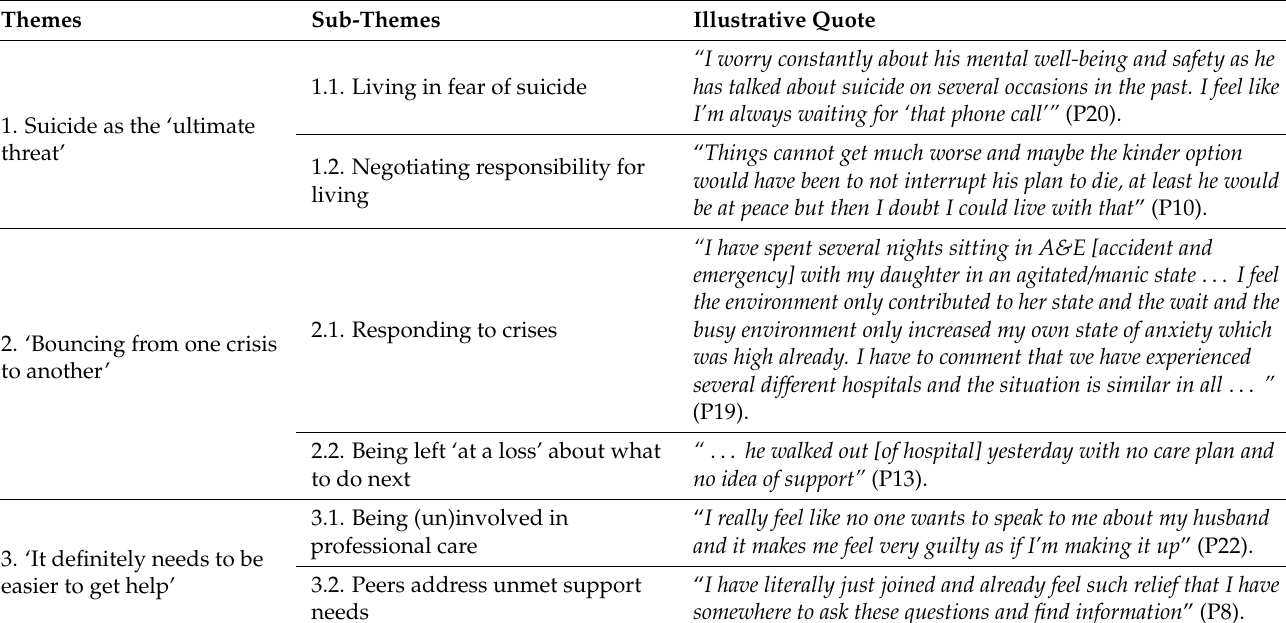
Table 2. Table of themes and